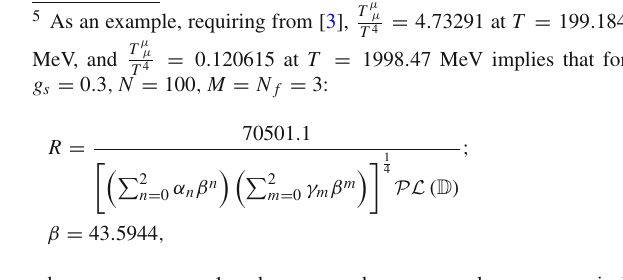
5 As an example, requiring from [3], T